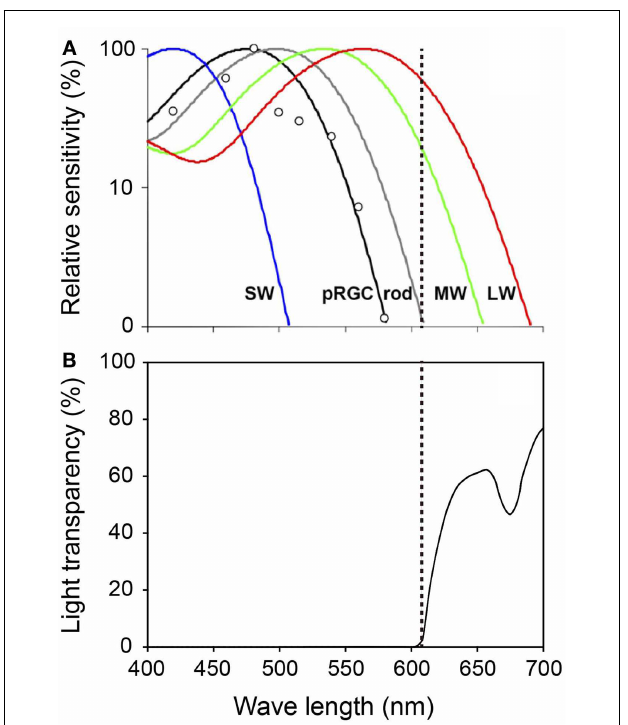
FIGURE 8 | Spectral properties of human photoreceptors and spectral transmission characteristics of the red filter . (A) Spectral sensitivity of rod, cones, and melanopsin measured by pupil responses to light. Maximum light sensitivity wavelengths of human rods (R), S cones (SW), M cones (MW), and L cones (LW) are approximately 500, 420, 530, and 560nm, respectively.The melanopsin (pRGCs) exhibit their peak sensitivity at around 480nm.The dashed line on the figure indicates 610nm. Figure cited by Zaidi et al. (61).White circles indicate the pupil responses to light in a blind woman. (B) Spectral transmission characteristics of the red filter. Note that the red filter cut light of wave lengths < 610nm perceived by melanopsin and rods, which function in preterm infants, while allowing wave lengths > 610nm perceived by adult MW and LW to pass